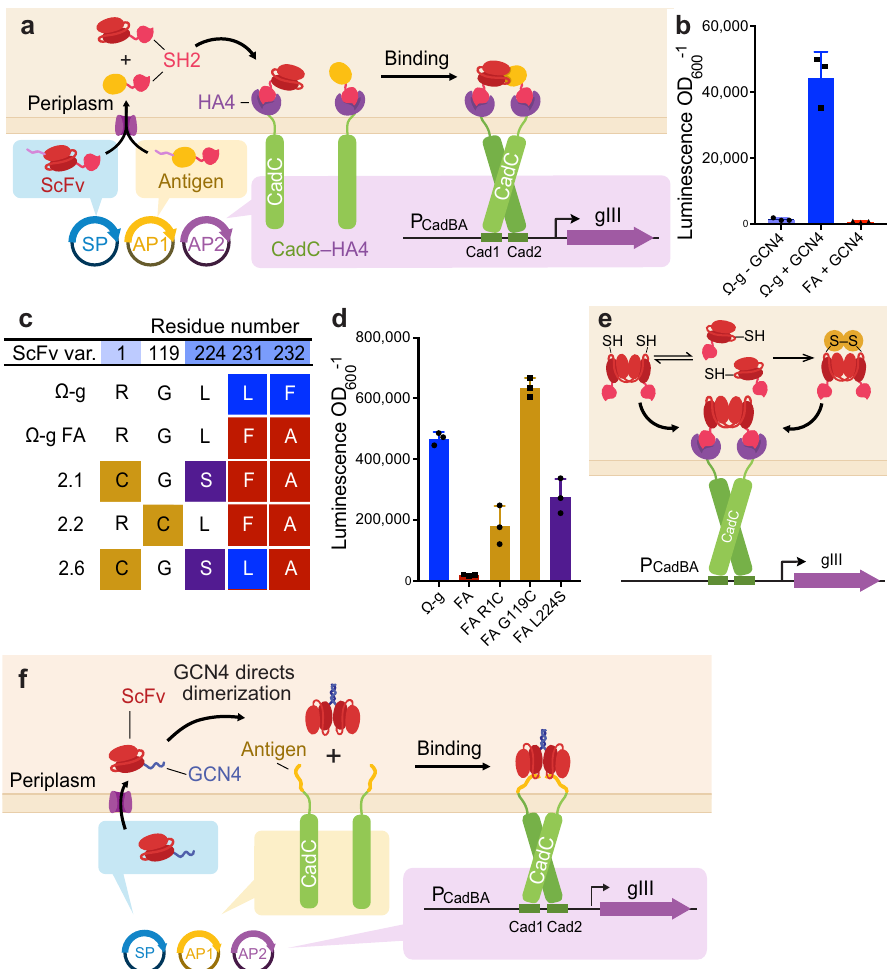
Fig. 3 Initial design of pPACE and mechanism of selection survival through homodimerization. a Schematic overview of initial selection design. b Luminescence-based transcriptional activation assay comparing the performance of Ω -graft (abbreviated Ω -g) to the L231F F232A (here abbreviated FA) binding mutant in the presence and absence of its cognate antigen, a monomeric form of GCN4(7P14P) (abbreviated GCN4 in b) in the system diagrammed in ( a ). c PACE generates multiple variants with spontaneous N-terminal or 4X GGGS linker cysteine residues in addition to variants reversing mutation L231F. Full results can be found in Supplementary Fig. 5b. d Transcriptional activation assay. In a non-binding background, N-terminal cysteines drive partial or complete restoration of P cadBA transcriptional activation, suggesting a mechanism of surviving the selection by the formation of novel disul fi de bonds that generate covalent homodimeric scFvs, as shown in ( e ). Homodimeric scFv – SH2 fusions are able to bind drive CadC – HA4 dimerization without the involvement of the antigen. Bar values and error bars in (b) and (d) represent the mean and s.d. of three independent biological replicates. ( f ) Novel selection architecture